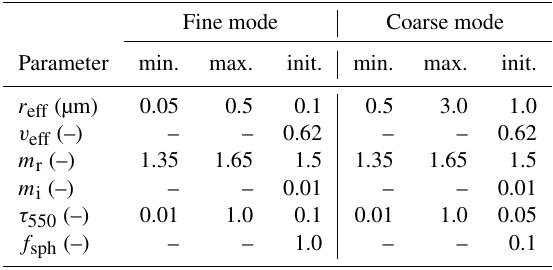
Table 3. Boundaries and initial values for the aerosol parameters used in the retrieval. For effective variance ( v eff ), the imaginary part of the refractive index ( m i ), and the fraction of spherical particles ( f sph ), no bounds are given, as these quantities are fixed. Fine mode Coarse mode